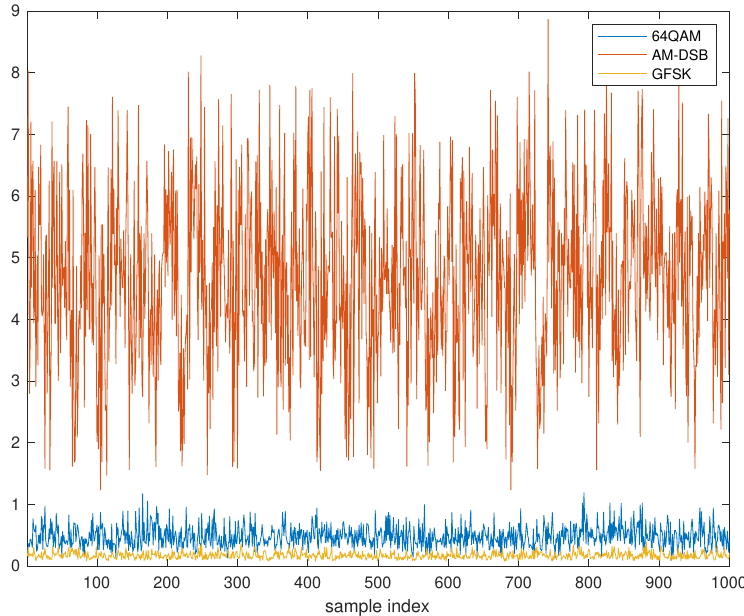
Figure 2. Squared norm of the projected data vectors, separated by the type of modulation. The sample rate refers to the signal frame